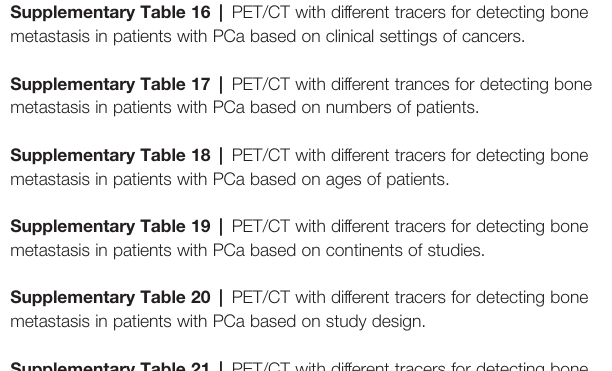
Supplementary Table 23 | PET/CT with different tracers and MRI with different numbers of sequences for detecting bone metastasis in patients with PCa. Supplementary Table 24 | PET/CT with different tracers and MRI with/without DWI for detecting bone metastasis in patients with PCa. Supplementary Table 25 | PET/CT with different tracers and MRI with different numbers of imaging planes for detecting bone metastasis in patients with PCa. Supplementary Table 26 | PET/CT with different tracers and MRI with different coverage for detecting bone metastasis in patients with PCa. Supplementary Table 27 | PET/CT with different tracers and MRI with different fi eld strength for detecting bone metastasis in patients with PCa by deleting studies with only one diagnostic test.